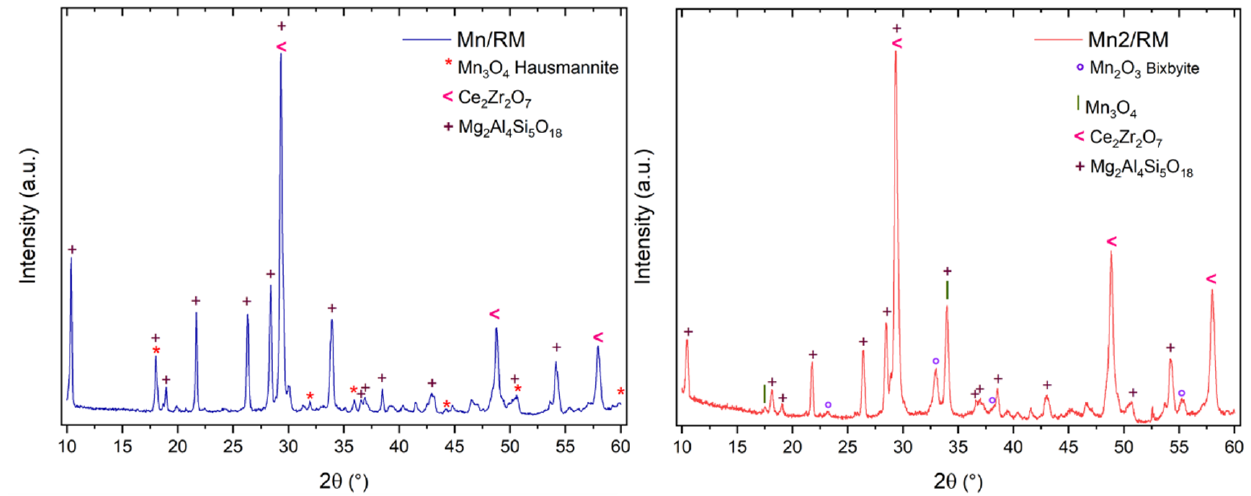
Figure 3. X-ray diffractograms obtained for the prepared catalysts.